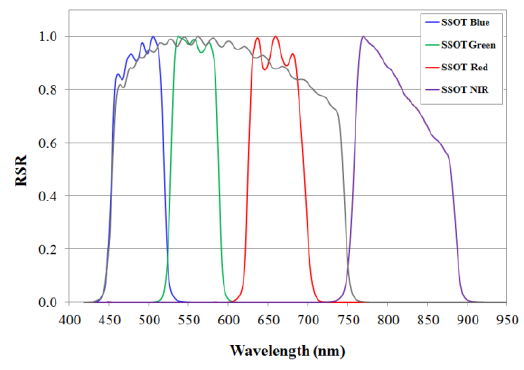
Figure 1. Relative Spectral Response (RSR) of the NAOMI - 1 sensor